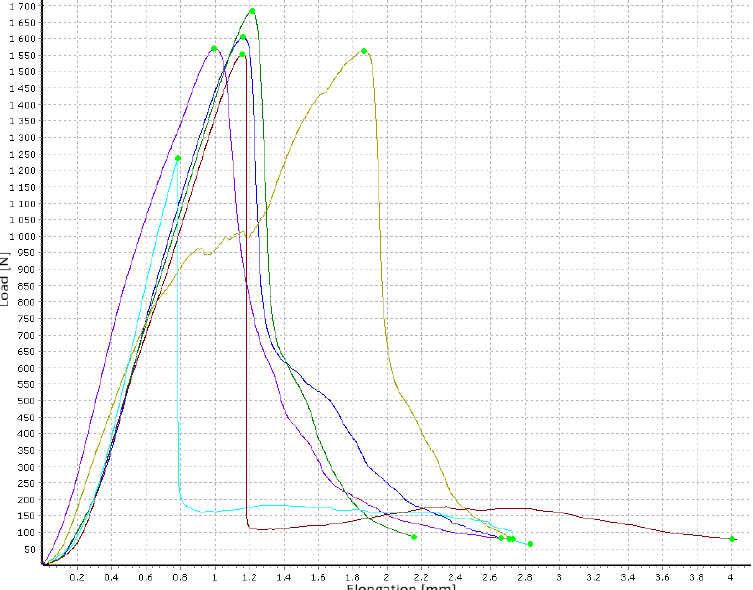
Figure 3. Example of tensile test results for measuring adhesive deformation on aluminium targets.